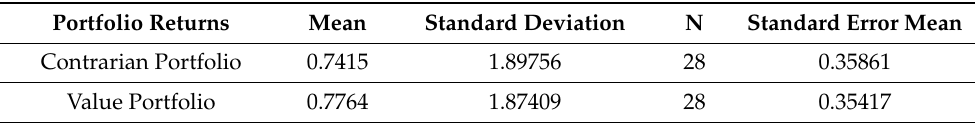
Table 8. Descriptive statistics of contrarian and value portfolio returns for year t +